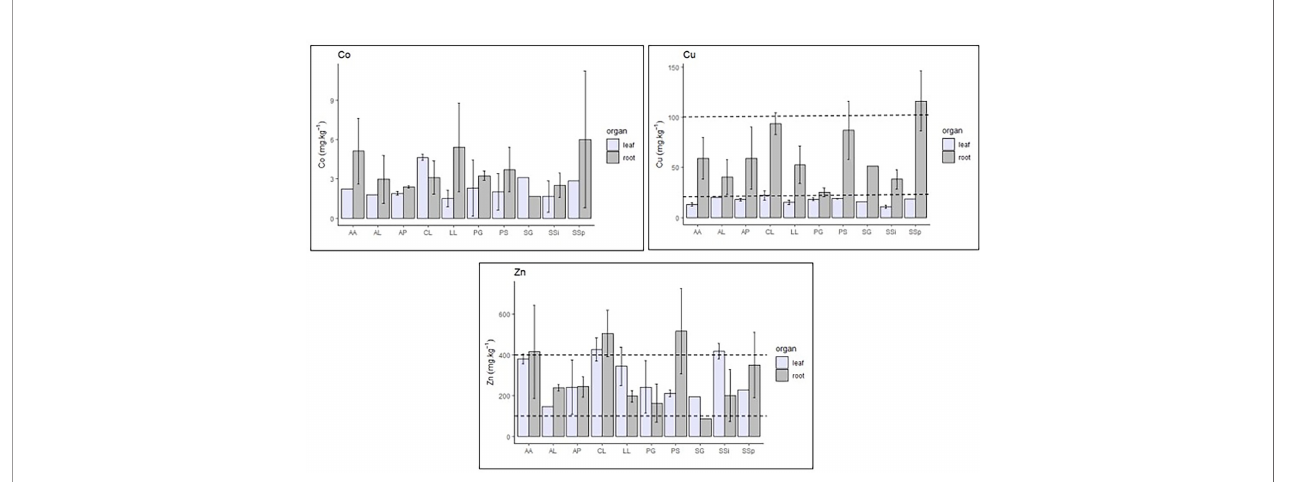
FIGURE 3 | Accumulation of Co, Cu, and Zn (mg kg − 1 ) in different tissues of trees on the tailings. AA: A. auriculiformis , AL: A. lebbeck , AP: A. polyacantha , CL: C. lusitanica , LL: L. leucocephala , PG: P. guajava , PS: P. sylvestris , SG: S. guineense , SSi: S. siamea , SSp: S. spectabilis . Dotted lines are normal ranges of trace elements in plants, Cu: 20 – 100 mg kg − 1 and Zn: 100 – 400 mg kg − 1 (12).